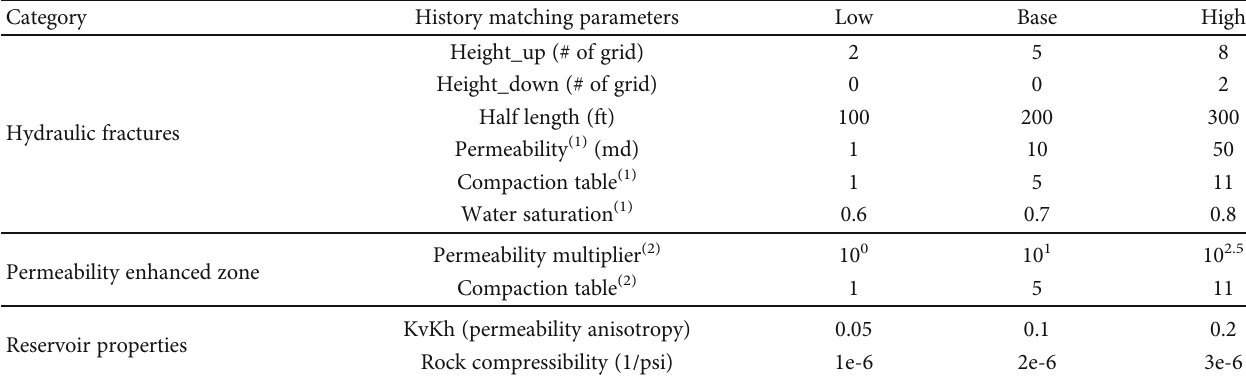
Table 3: History matching parameters. The superscript (1) indicates fractures for well A and well B that can have di ff erent values, and (2) indicates each permeability enhanced zone that can have di ff erent